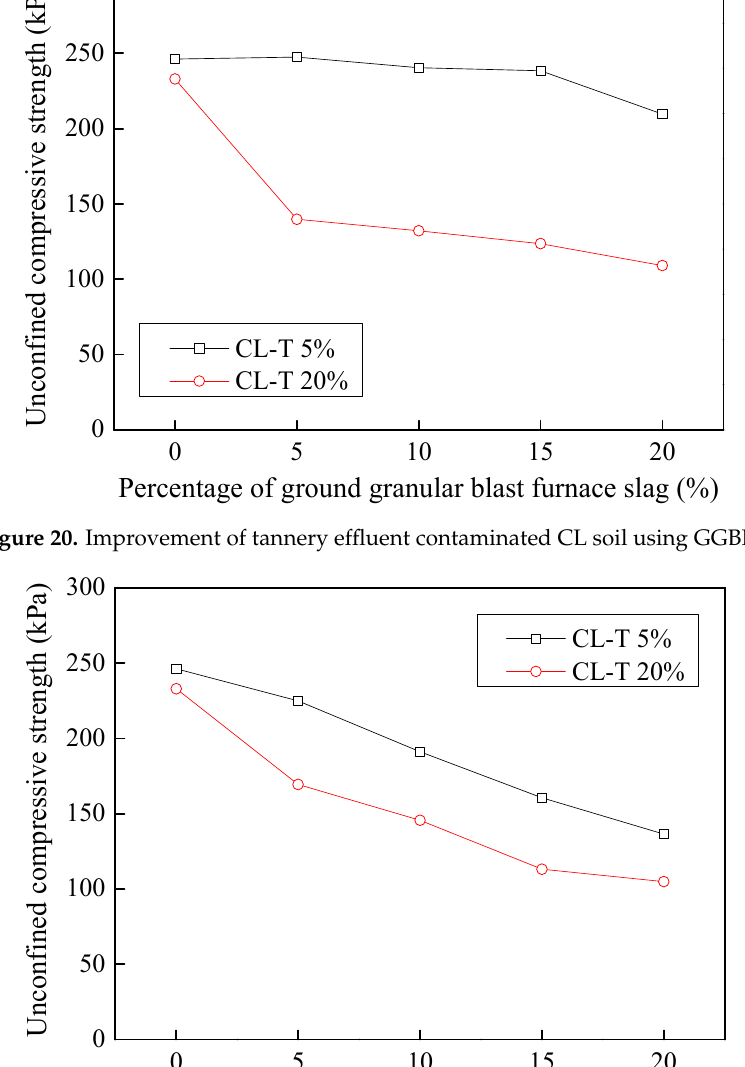
Figure 22. Improvement in dyeing effluent contaminated CH soil using marble dust.